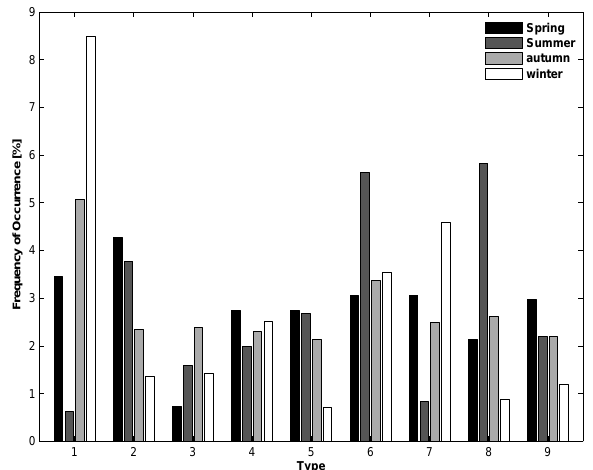
Fig. 3. Seasonal variation of frequency of the nine circulation types during